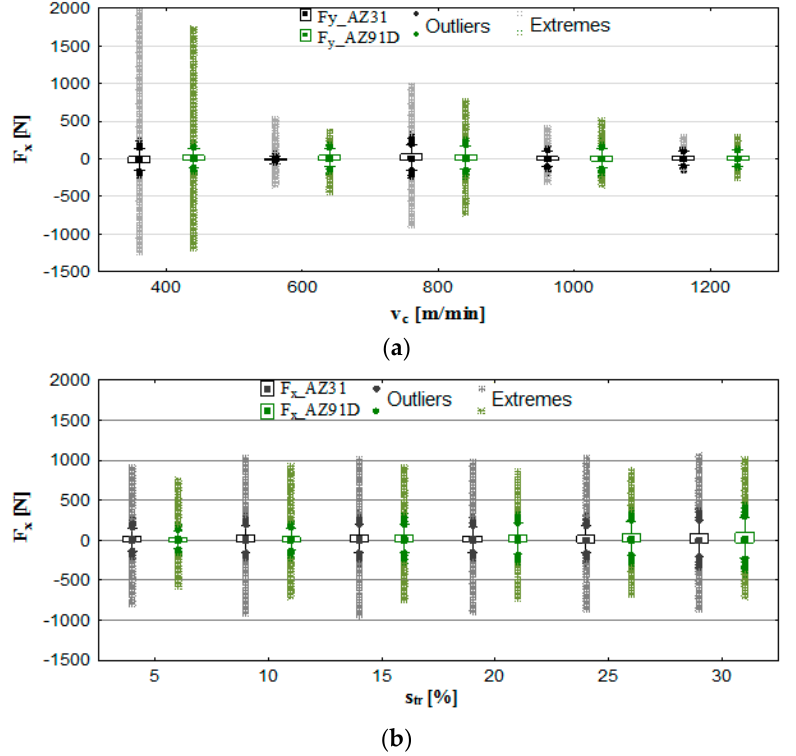
Figure 4. Effect of cutting speed and trochoidal step on cutting force component F x in milling of magnesium alloys: ( a ) v c (f z = 0.15 mm/tooth, a p = 6 mm, s tr = 15%) and ( b ) s tr (v c = 800 m/min, f z = 0.15 mm/tooth, a p = 6 mm).